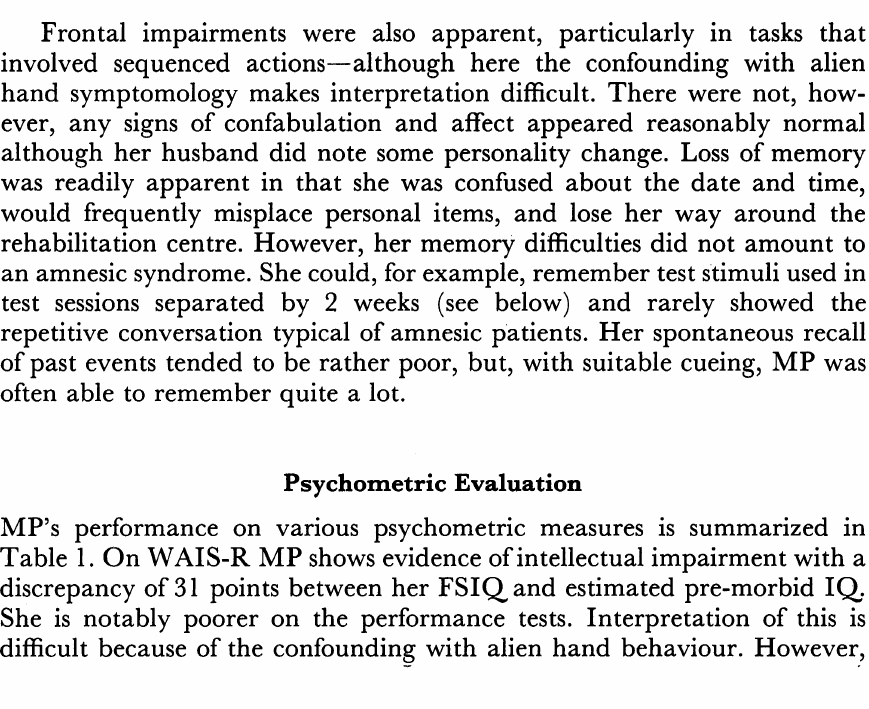
TABLE I. Performance of MP on psychometric